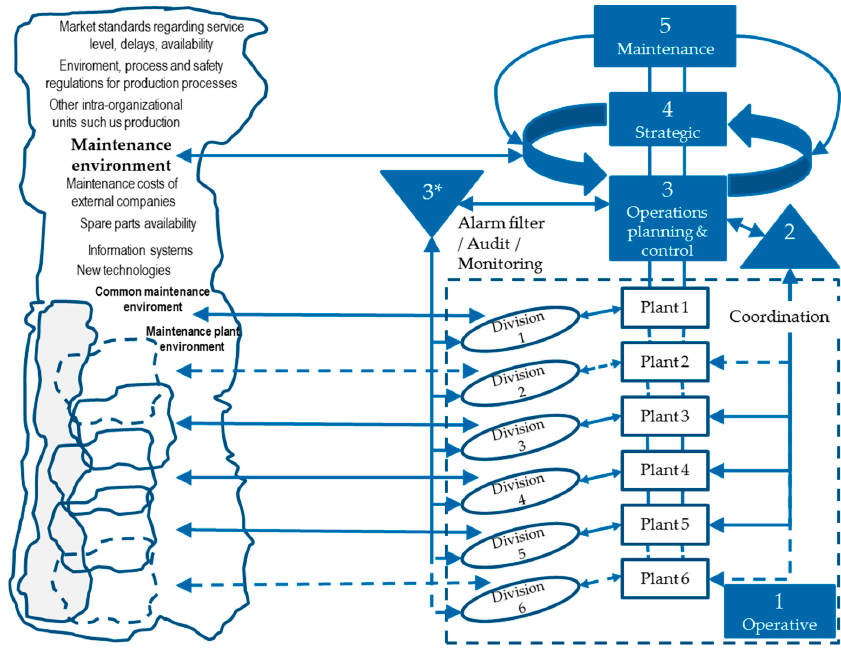
Figure 7. VSM analogy with maintenance management (own elaboration).